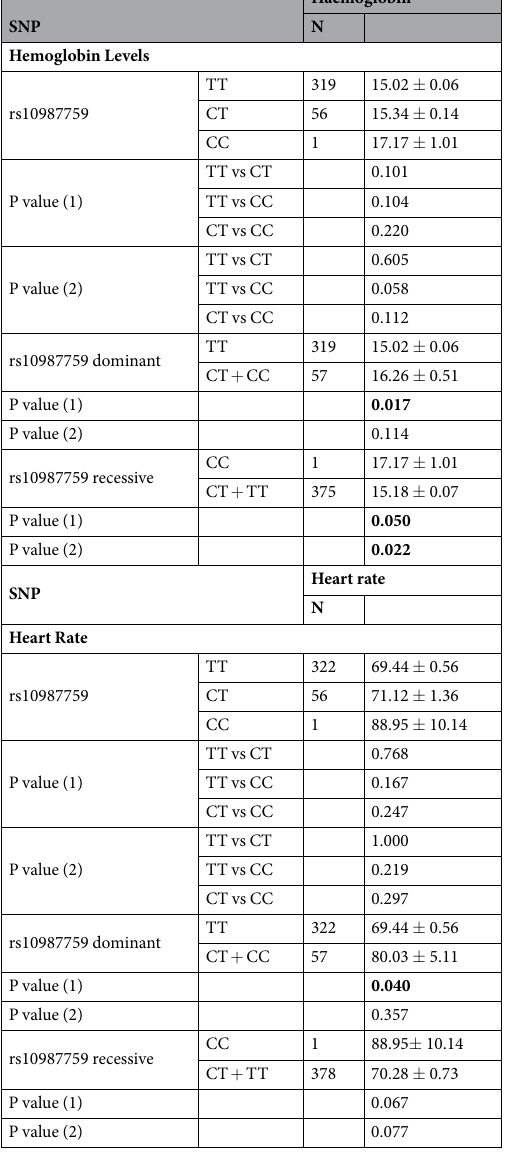
Table 8. Statistically significant results in the distribution of endoglin rs10987759 polymorphisms according to hemoglobin levels and heart rate. P value adjusted by sex and age (1) and by sex, age, DM, HTA, DL, tobacco, alcohol and BMI (2). SNP: single nucleotide polymorphism. Statistically significant results in